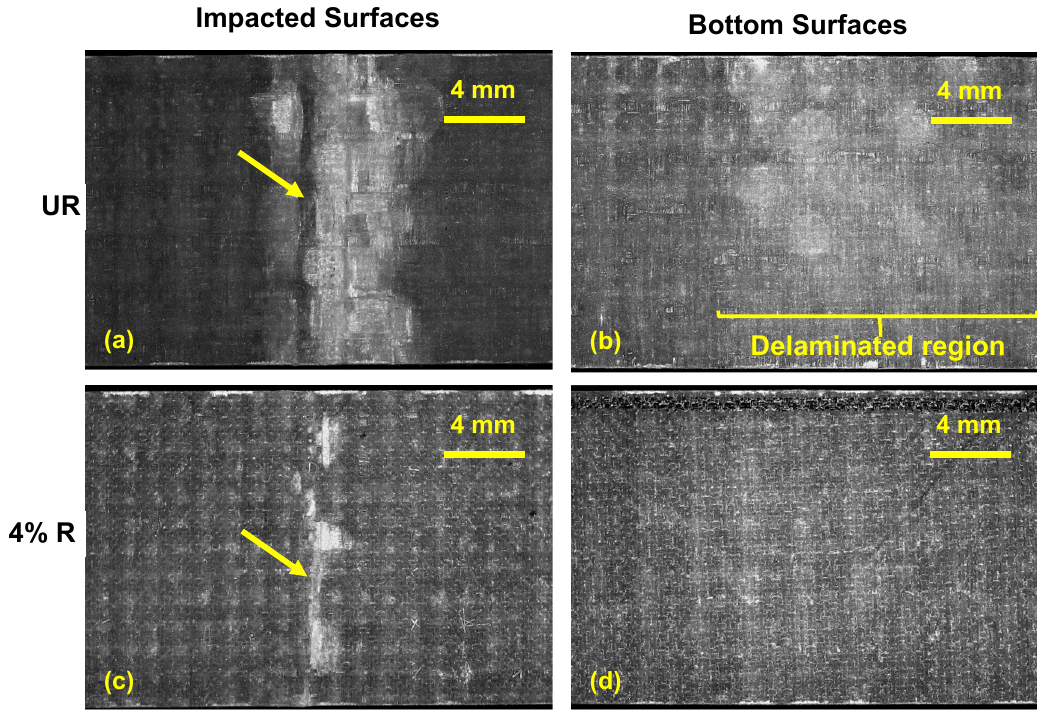
Figure 3. Visible impact damage to the impacted and bottom surfaces of ( a , b ) the unreinforced specimen and ( c , d ) the 4% chopped fiber-reinforced specimen.